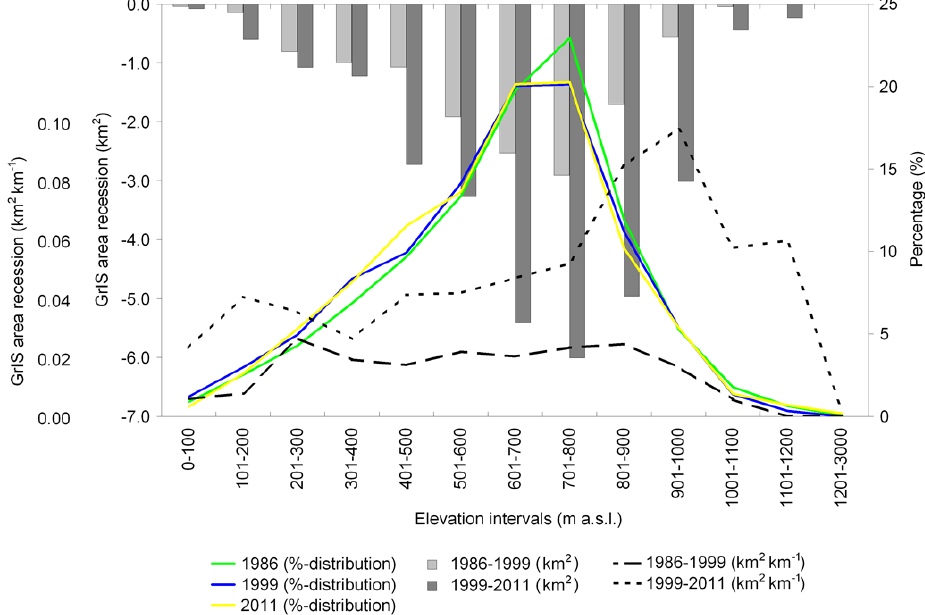
Fig. 8. GrIS land-terminating area recession rates for different elevation intervals, Ammassalik region, for the sub-periods 1986–1999 (light gray) and 1999–2011 (dark gray), area recession rate related to changes in margin length for 1986–1999 (black dashed line, long dashed) and 1999–2011 (black dashed line, short dashed), and the percentage of margin elevation for the different elevation intervals for the years 1986 (green), 1999 (blue), and 2011 (yellow) (see Fig. 7 for location of the